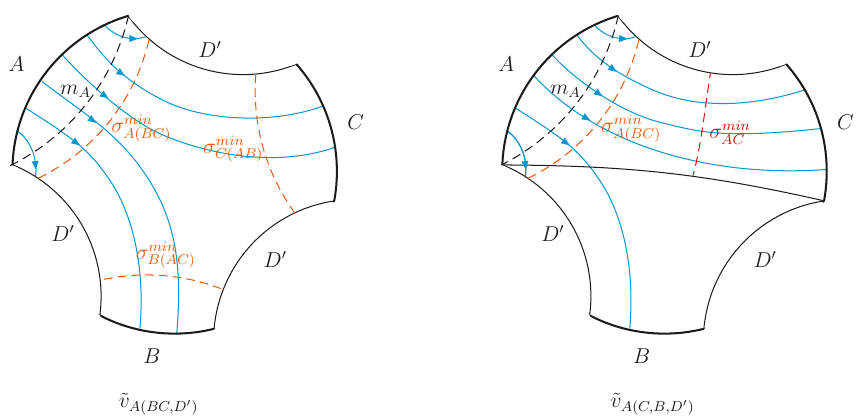
Figure 6 . Left: the vector (cid:12)eld ~ v , a (cid:13)ow that simultaneously maximizes the (cid:13)ux A ! (cid:22) A A ( BC;D 0 ) (bounded above by the area of m A ) and the (cid:13)ux A ! BC (bounded above by the area of (cid:27) min